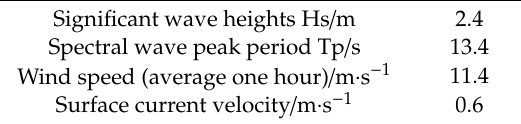
Table 6. Environmental parameters of typical sea conditions in China.